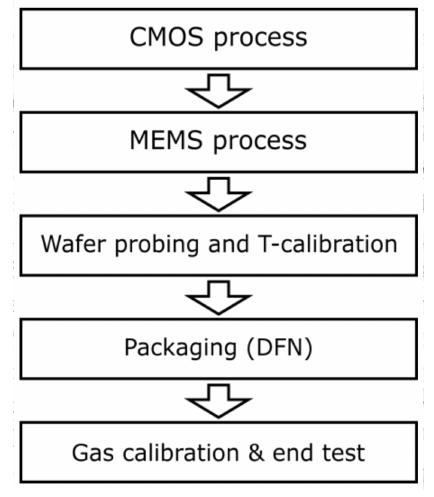
Figure 3. Process